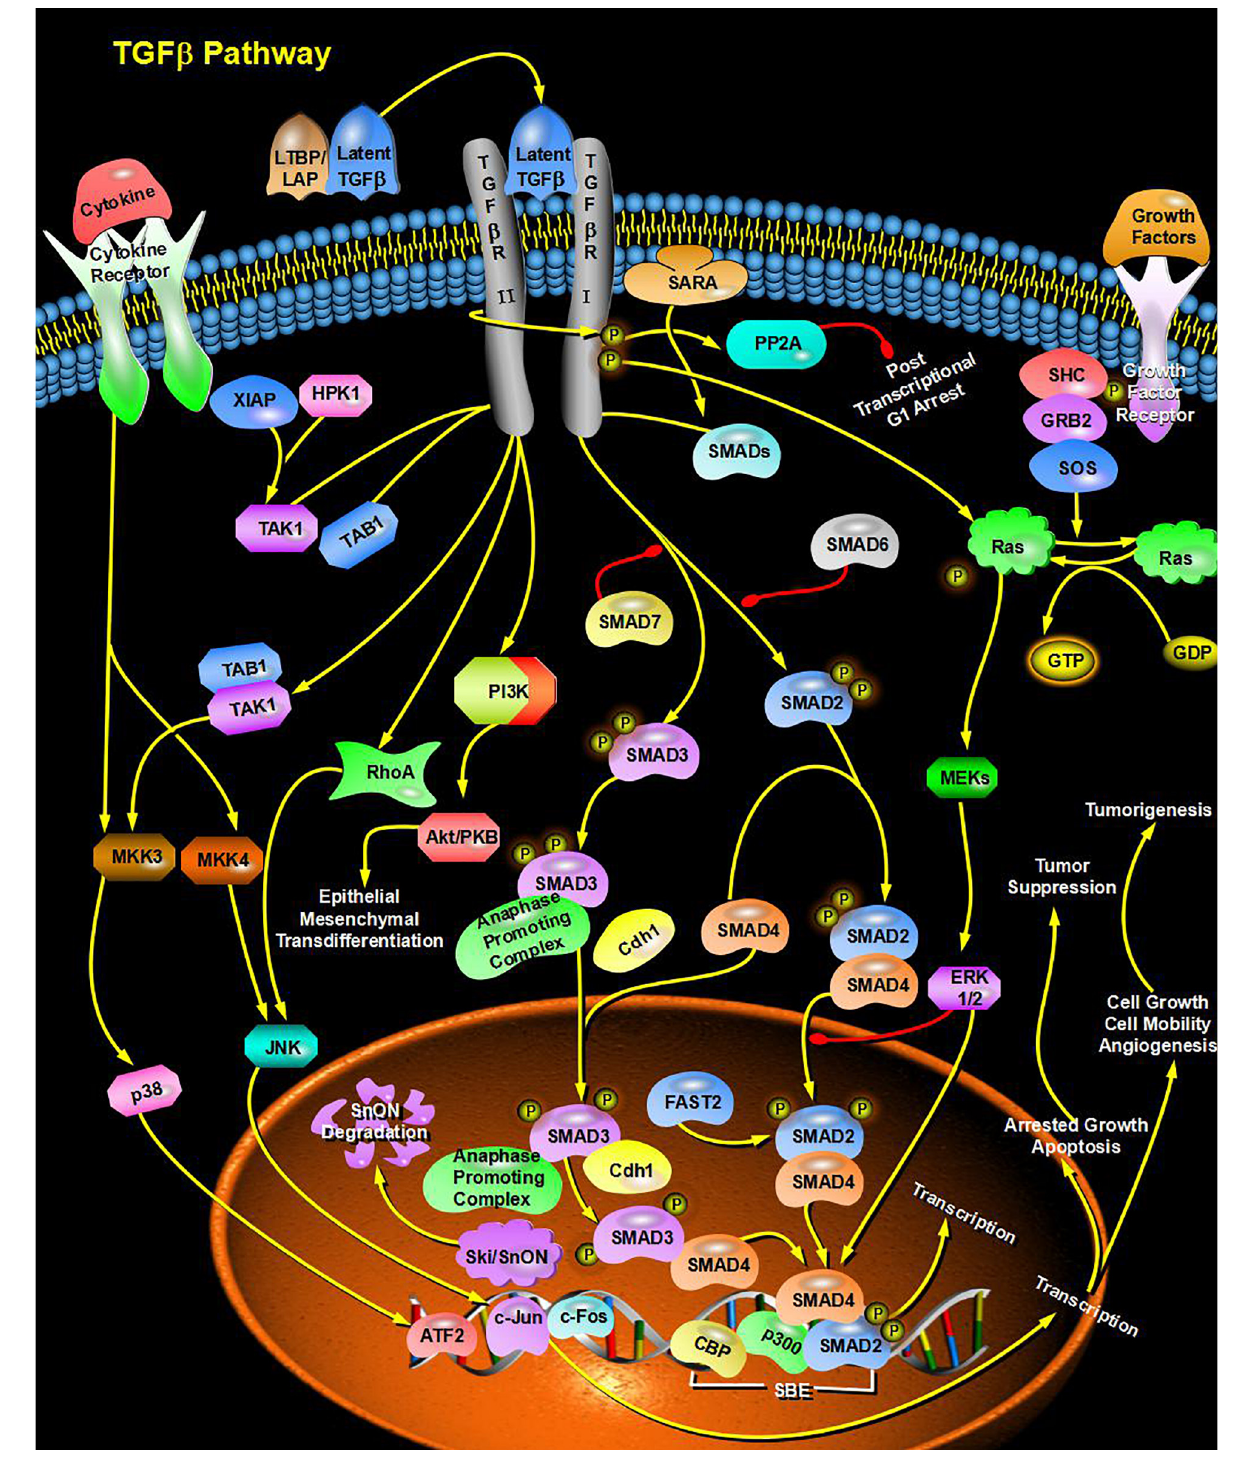
FIGURE 5 | miRNA promotes signal transduction and glucose protein binding through the TGF-beta signaling pathway and participates in the regulation of diabetes.